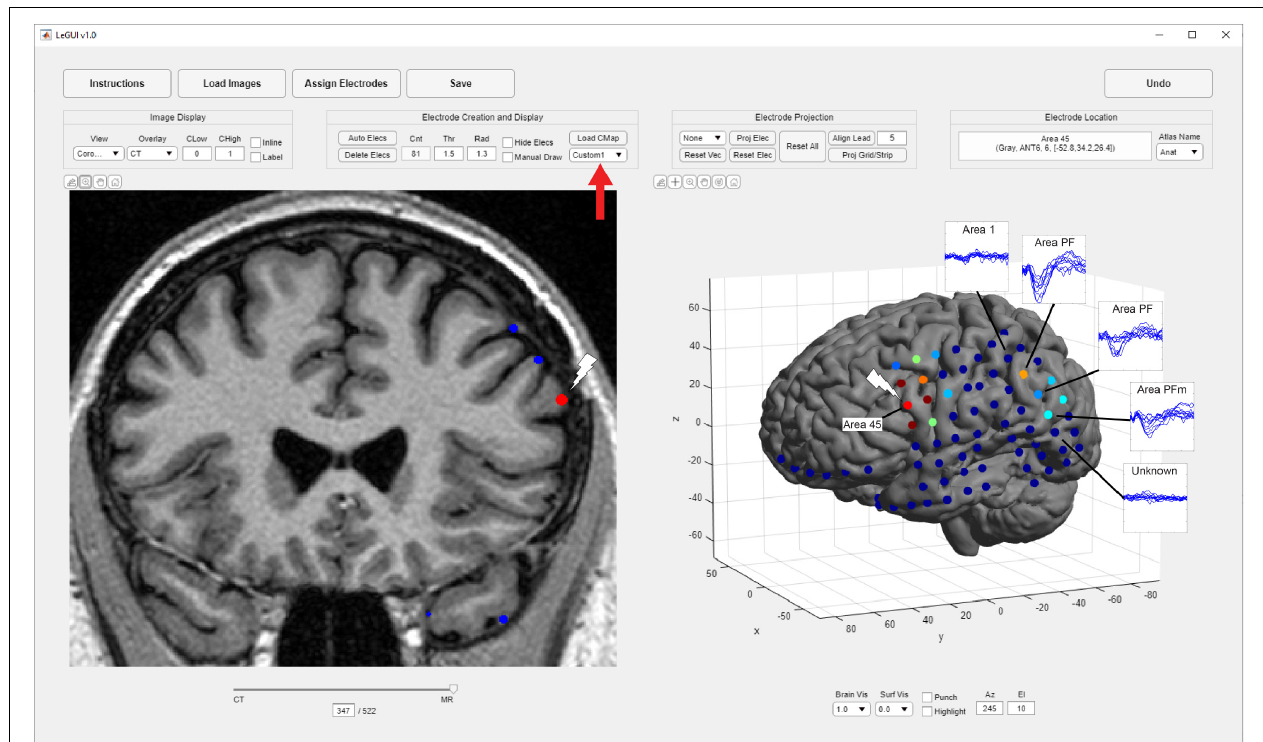
FIGURE 6 | Corticocortical evoked potentials (CCEPs) demonstrate a connection between the inferior frontal lobe (IFL) and the inferior parietal lobule (IPL). Single-pulse stimulation was applied to an ECoG electrode in area 45 of IFL (white lightning bolts), and CCEPs were recorded in areas PF and PFm of IPL (blue traces) demonstrating functional connectivity between these areas. These traces are overlaid for the purposes of this figure and are not a feature of LeGUI. Locations were determined using a cytoarchitectural atlas (SPM Anatomy toolbox) by selecting electrodes and viewing the corresponding anatomical locations in LeGUI (upper right). A custom colormap was used to color electrodes based on CCEP size (red = largest, blue = smallest). The colormap was loaded using a dropdown menu provided in LeGUI (red